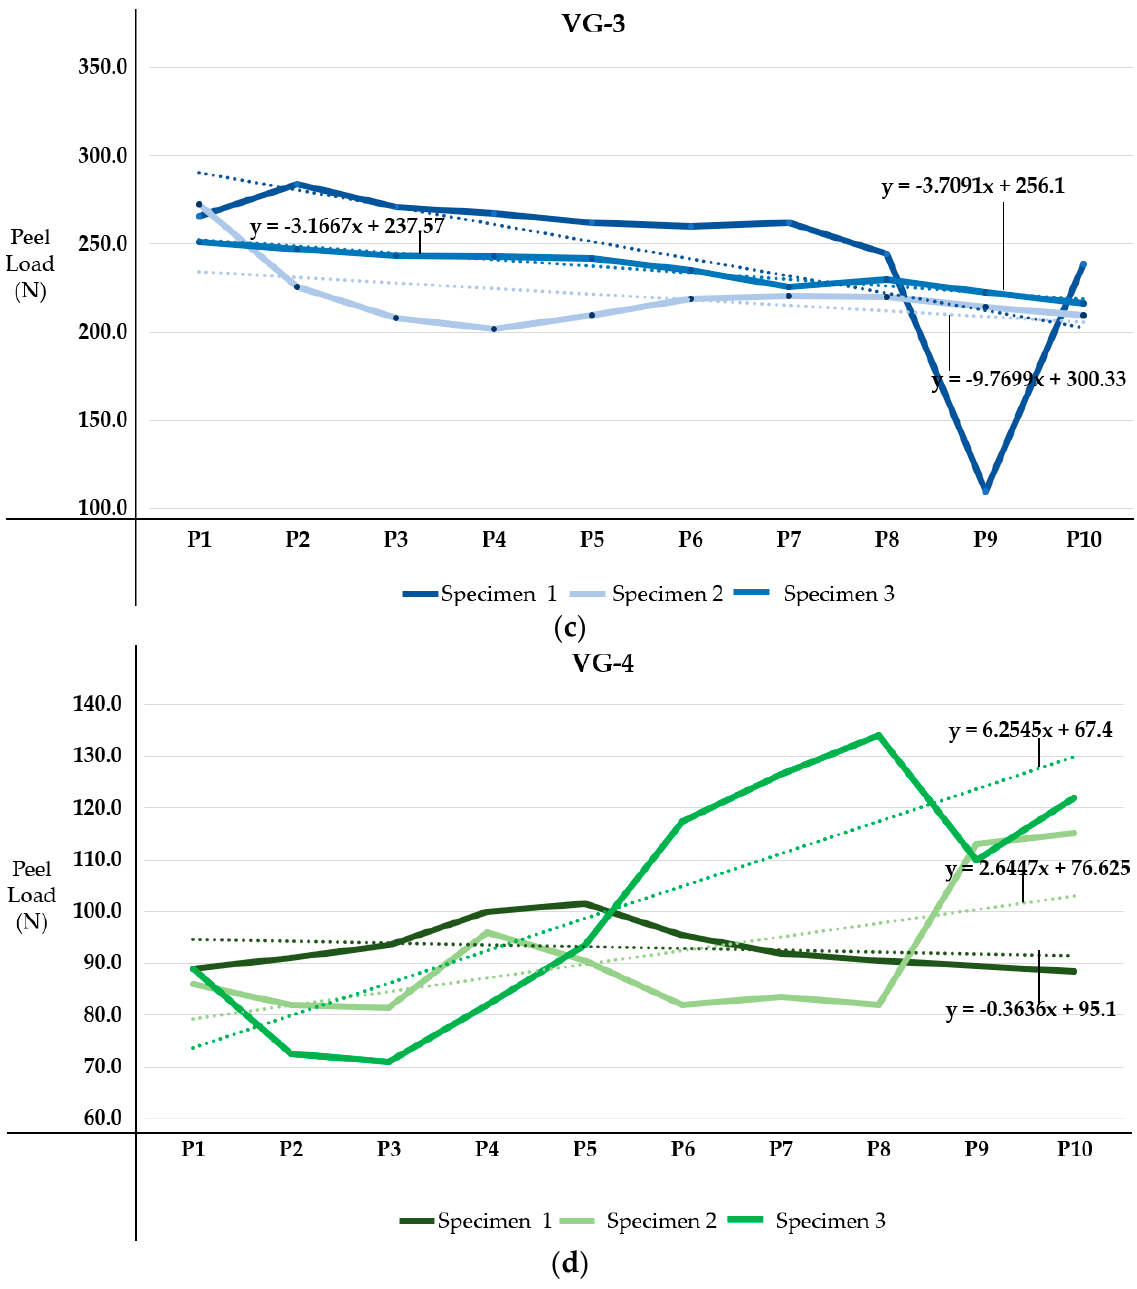
Figure 12. The specimen linear regression slope derivation for grade calculation; ( a ) VG 1, ( b ) VG 2, ( c ) VG 3, ( d ) VG 4.